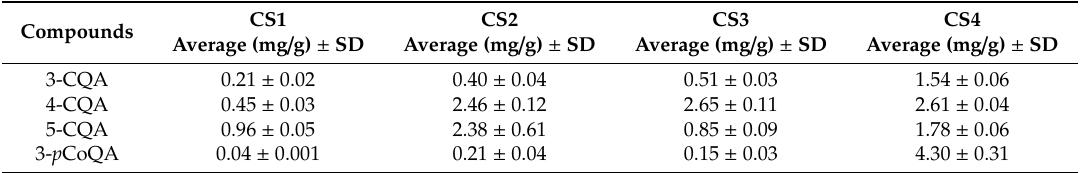
Table 3. Chlorogenic acids’ (CGAs) content in the analyzed CS extracts. Results are shown as the mean value ± SD ( n =